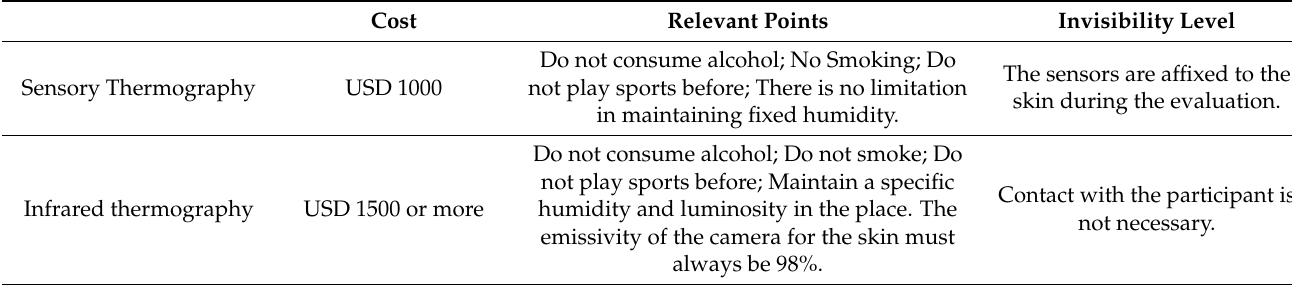
Table 7. Qualitative analysis between ST and